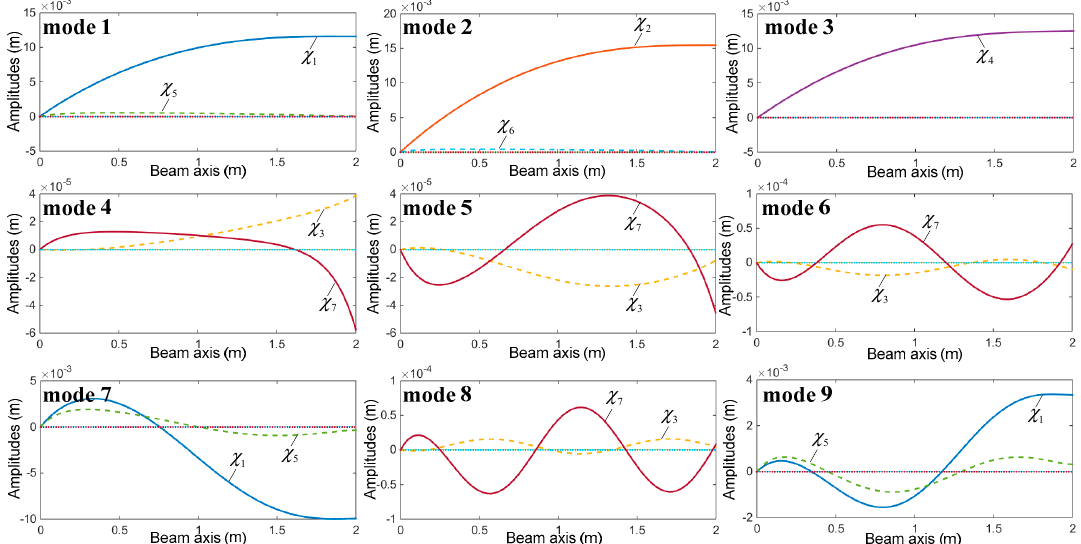
Figure 11. Longitudinal variations of the out-of-plane generalized displacements of the thin-walled structures, in free vibration analysis.